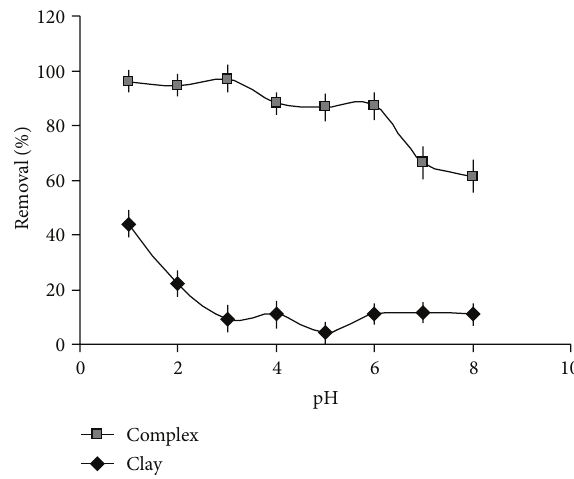
Figure 1: Effect of the initially adjusted pH on the removal of chromium by micelle-clay complex ( ◼ ) and pure clay ( Q ). Initial concentration of Cr(VI) = 50mg L −1 , contact time = 3h, tempera- ture = 25.0 ± 0.2 ∘ C, and adsorbent dosage = 5.0 gL −1 . Data represent averages of total-Cr triplicate measurements (AAS) ± SE.